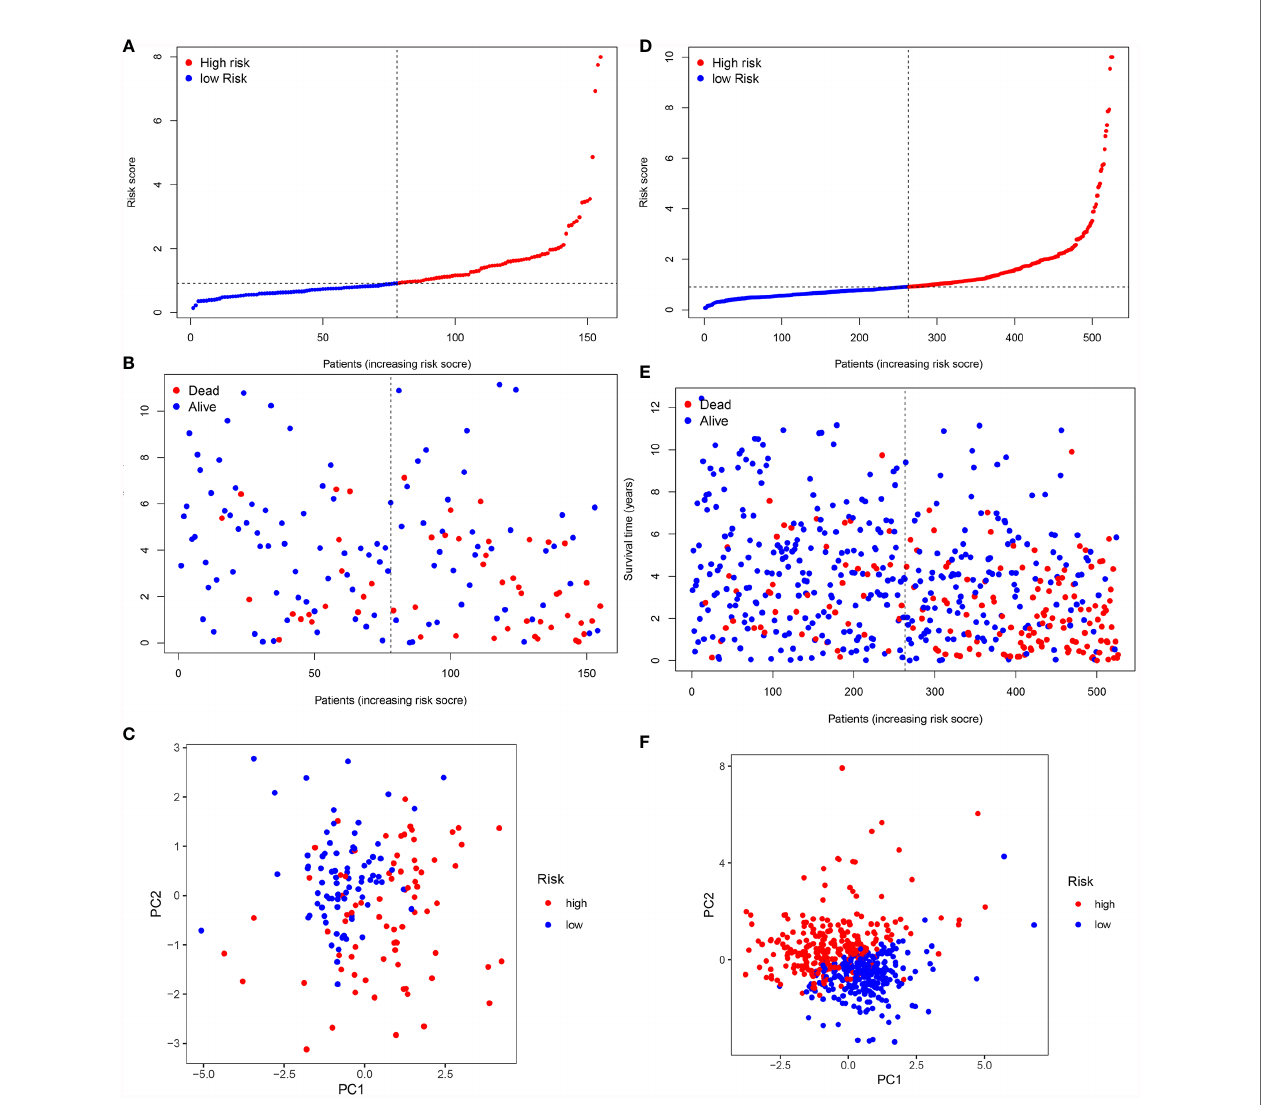
FIGURE 7 | Validation of the signature in the validation cohorts. (A, D) Risk score distribution of patients in the testing cohort (A) and the entire TCGA cohort (D) . (B, E) . Survival status scatter plot of patients in the testing cohort (B) and the entire TCGA cohort (E) . (C, F) PCA plot in the testing cohort (C) and the entire TCGA cohort (F)